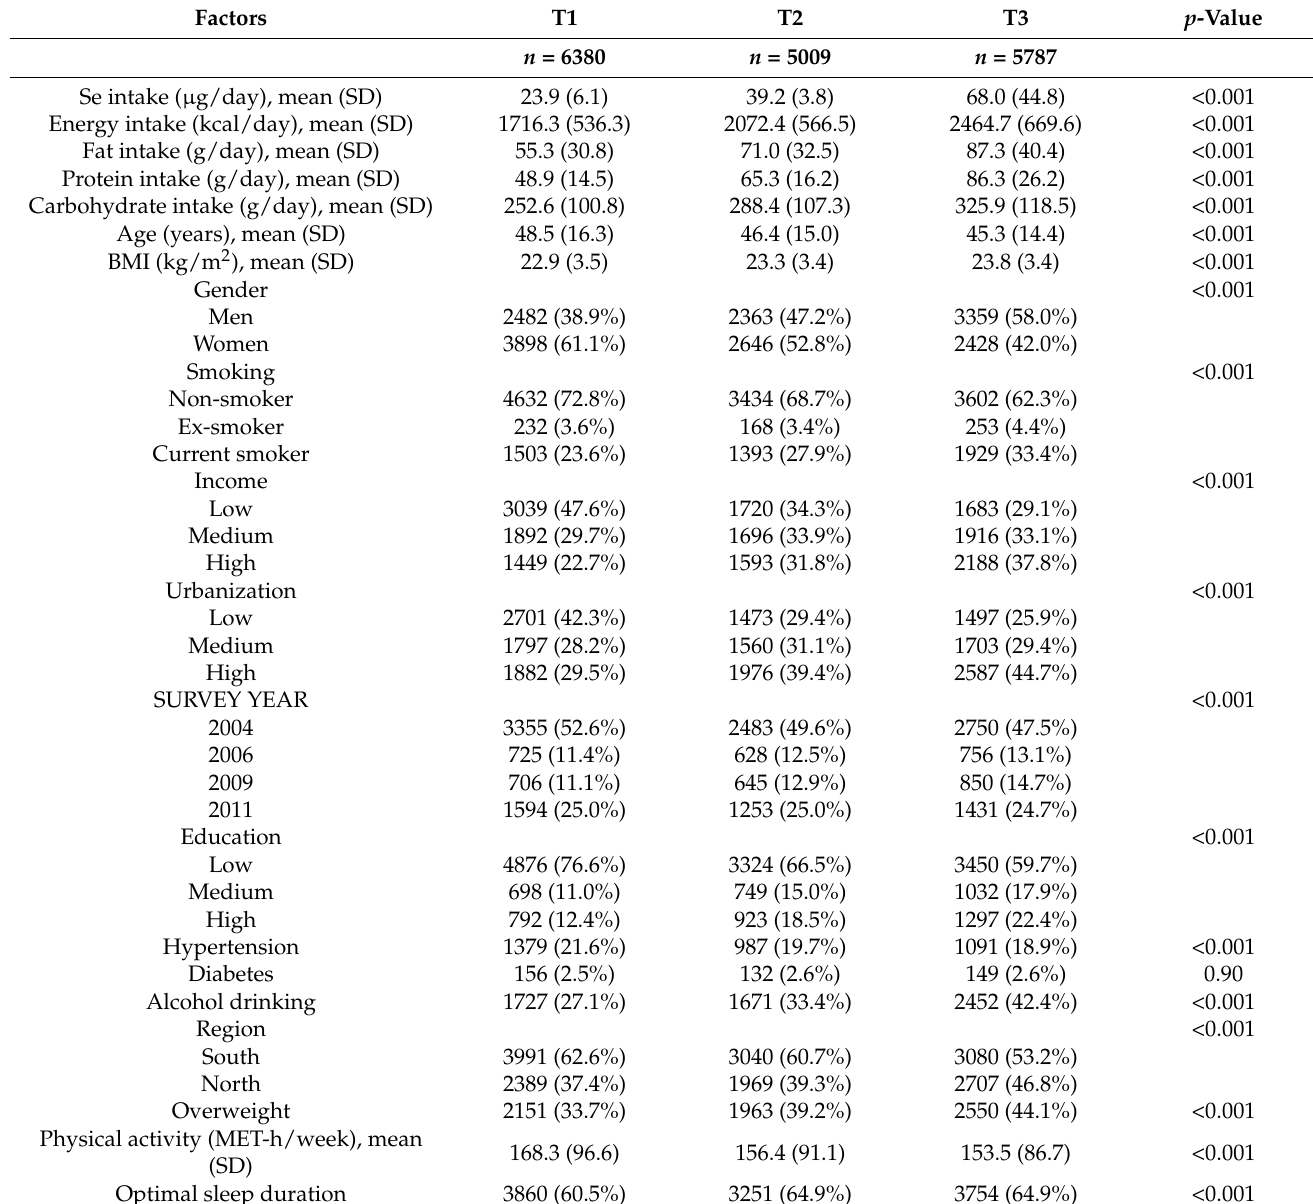
Table 1. Baseline sample characteristics of Chinese adults attending CHNS by tertiles of cumulative selenium intake ( n =